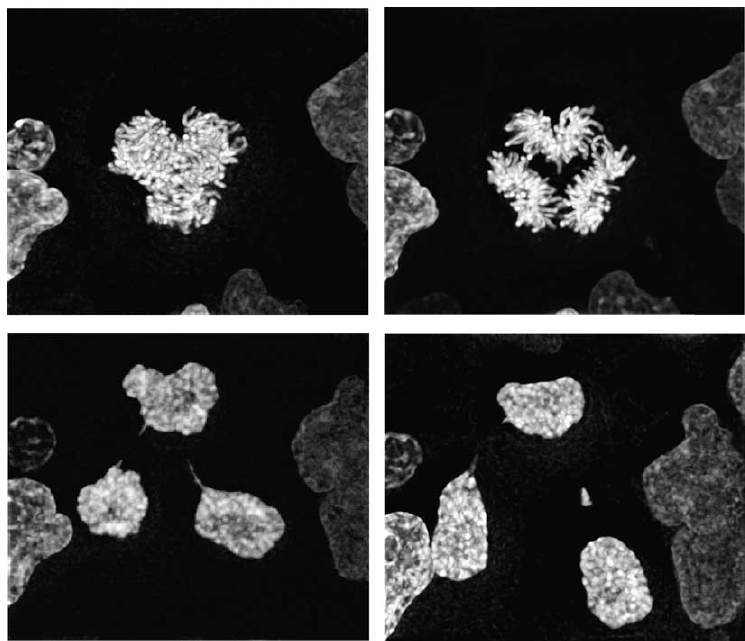
Fig. 2. Chromosome missegregation in a human prostate tumor cell. PC-3 cell line constitutively expressing histone H2B fused to green fluores- cent protein (GFP) to label chromosomes. Cells were examined by fluorescence time lapse imaging using optical sectioning and deconvolution to obtain three-dimensional images. Three-dimensional images are displayed as two-dimensional projections. Images: Agata Jurczyk and Steve